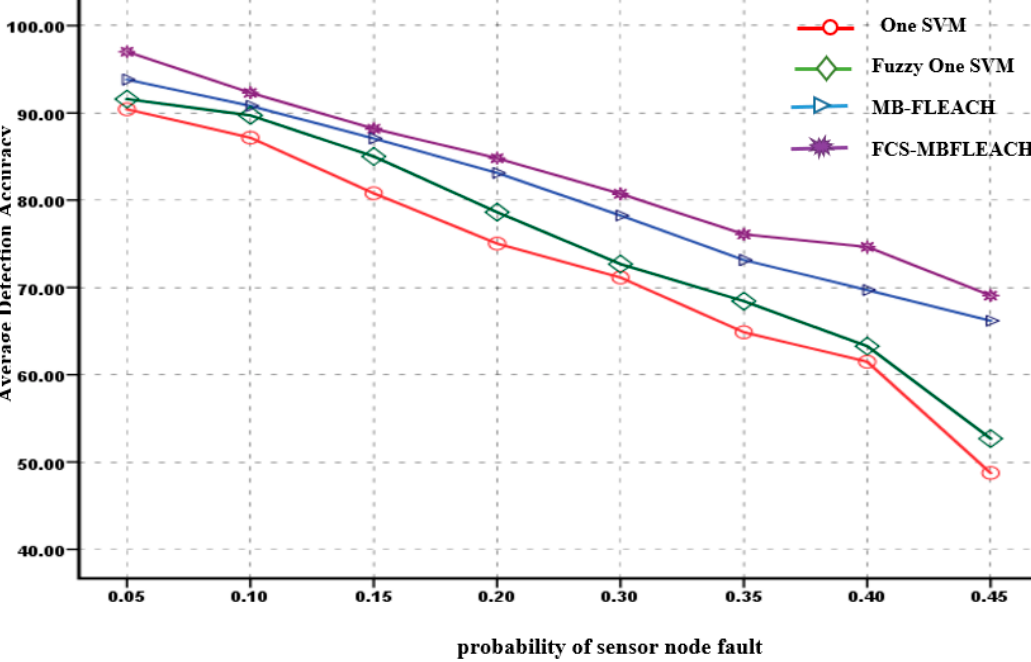
Figure 10. Average detection accuracy of sensor node faults with a density equal to 10 for the second scenario.